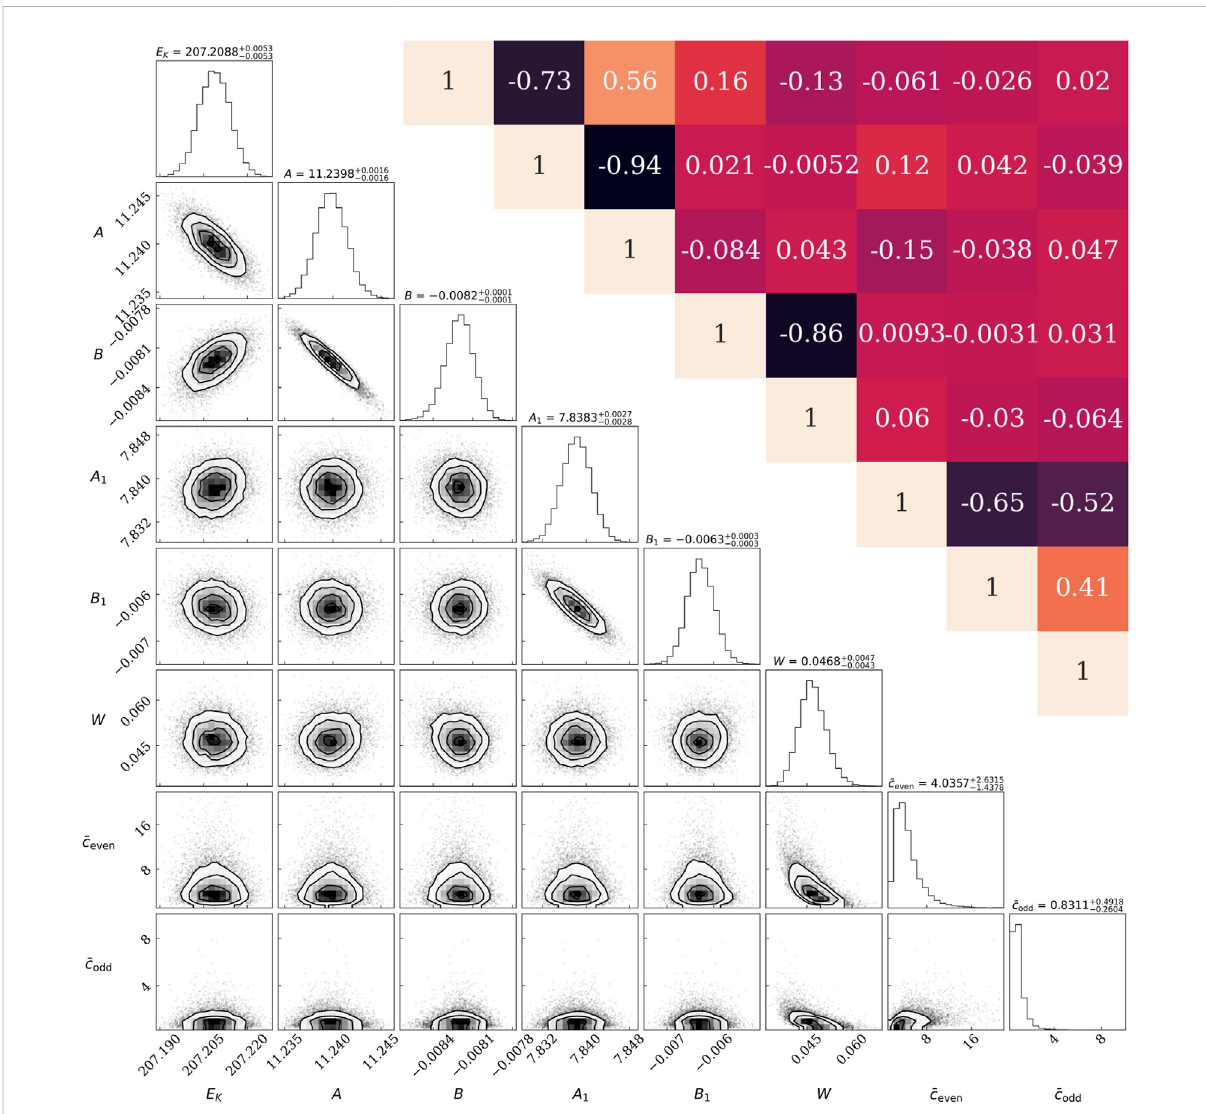
FIGURE 3 Corner plot for the marginalized distributions of the LECs and the error-model parameters at N 4 LO for 167 Er including all adopted rotational levels(